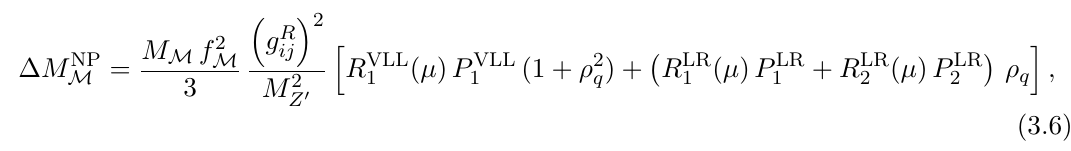
After matching the operators of eqs. (3.2){(3.5) to the full theory we (cid:12)nd with the o(cid:11)-diagonal matrix element M (cid:3) = hMjH (cid:1) S =2 jMi for the mass splitting [19] 12 e(cid:11)